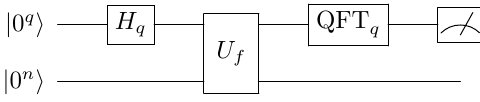
Figure 10: Quantum circuit Q Shor